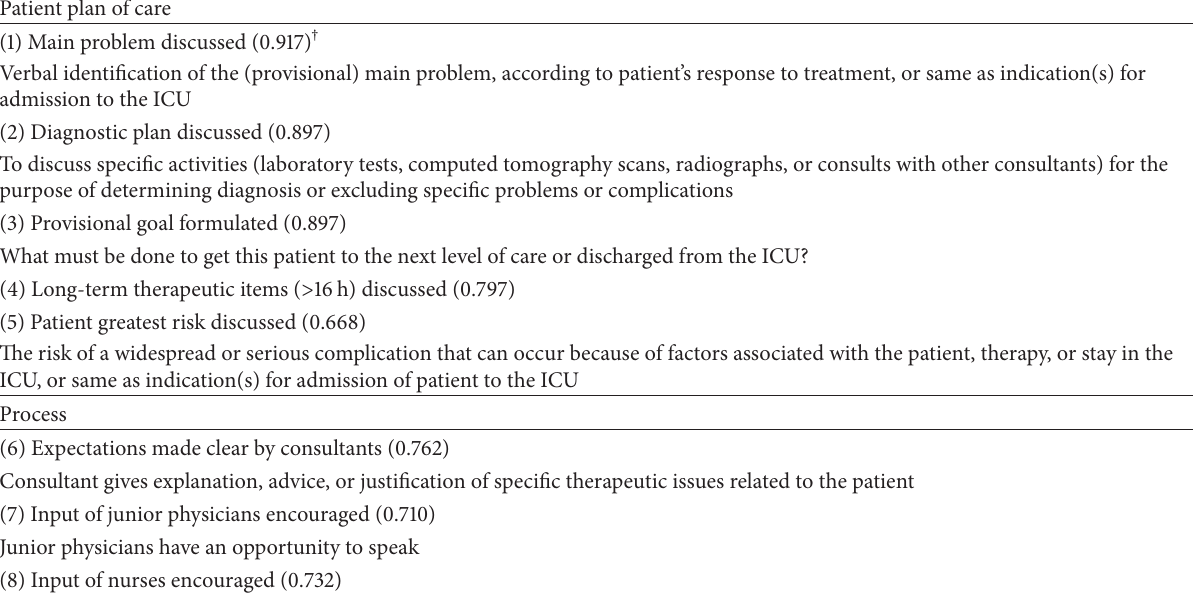
Table 1: Definitions of the 10 essential quality indicators of the checklist ∗